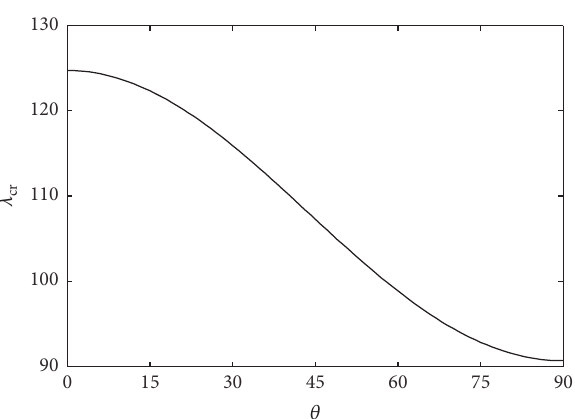
Figure 4: Flutter boundary versus orientation angles of SMA wires.